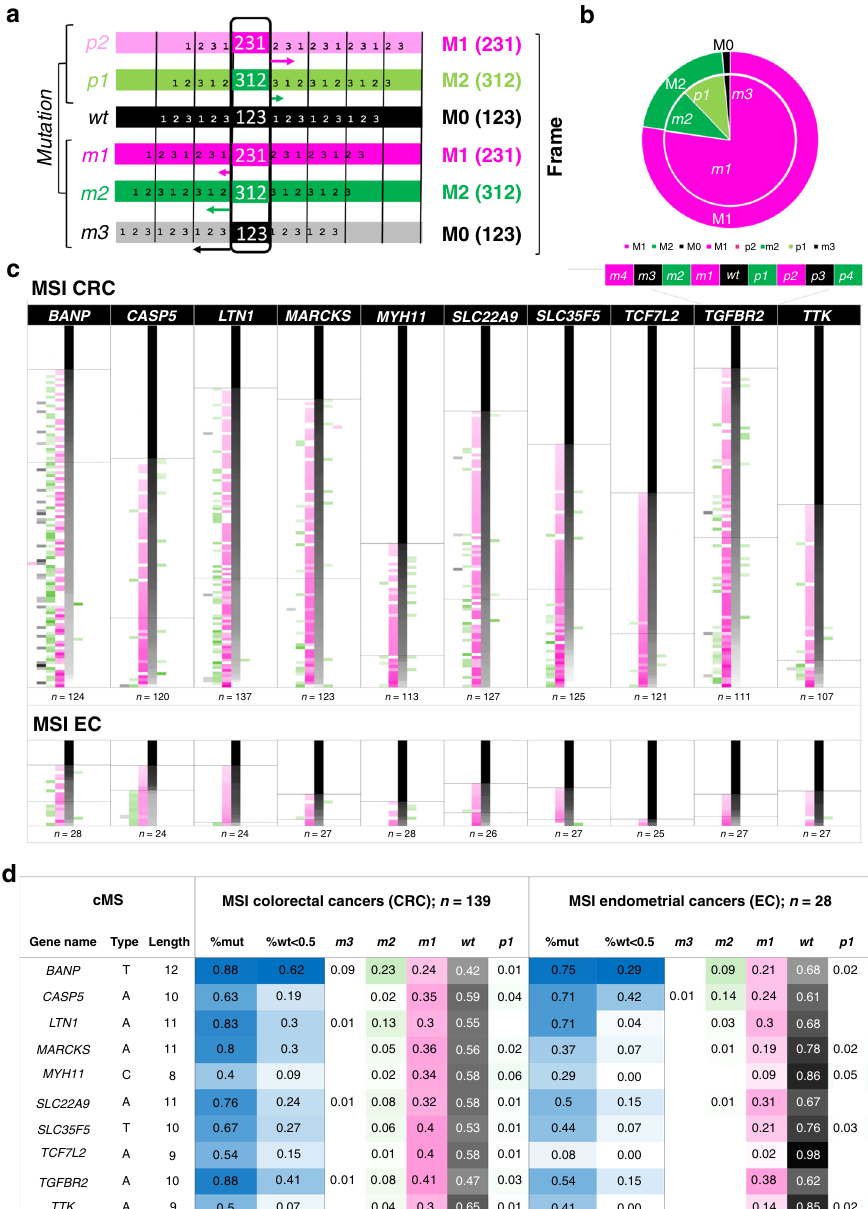
Fig. 2 Mutational pattern distribution in cMS based on ReFrame analysis. a Scheme of frameshift mutations (m3, m2, m1, wt, p1, p2) on the left and their corresponding frames (M0, M1, M2) on the right. The numbers 1 – 3 indicate base triplets in the corresponding frame. Arrows mark the shift between the wt frame and the alternate frame. b Distribution of all cMS frameshift mutations (m3 – p2) and their corresponding frames (M0, M1, M2) in MSI CRC quanti fi ed using ReFrame. Mutations in all MSI CRC samples were classi fi ed in corresponding reading frames (M0, black; M1, magenta; M2, green) and their overall allele ratios quanti fi ed. c The detailed mutational patterns of ten representative cMS are depicted with their respective frequency of mutation for all possible resulting frameshift mutations (m4 – p4) in MSI CRC and EC (see Supplementary Fig. 3 for complete dataset). Each row constitutes one analyzed tumor sample with its related allele ratios. For each cMS, tumors were sorted by the proportion of wild-type alleles top to bottom. The number of samples analyzed for a certain candidate is indicated below each candidate ’ s fi gure. Color indicates the resulting reading frames as in b . Intensities represent ReFrame-calculated ratios from white (0%) to full-intensity magenta/green/black (100%) according to the resulting reading frame of the column. The annotated solid lines ( fi rst horizontal line top down) show the end of the non-mutated tumor samples (cutoff: 15%), while the dotted lines (second horizontal line top – down) mark the beginning of tumors being >50% mutated, associated with biallelic hits within the respective sample. Source data are available as a Source Data fi le. d Calculated mutation frequencies and mean allele ratios of most common indel mutation types (m3 – p1) resulting from ReFrame analysis in ten representative cMS candidates sorted by length. %mut proportion of mutant tumors, %wt<0.5 proportion of tumors with biallelic hits. Columns m3 – p1 display average frequencies of the respective indel mutations over all the samples